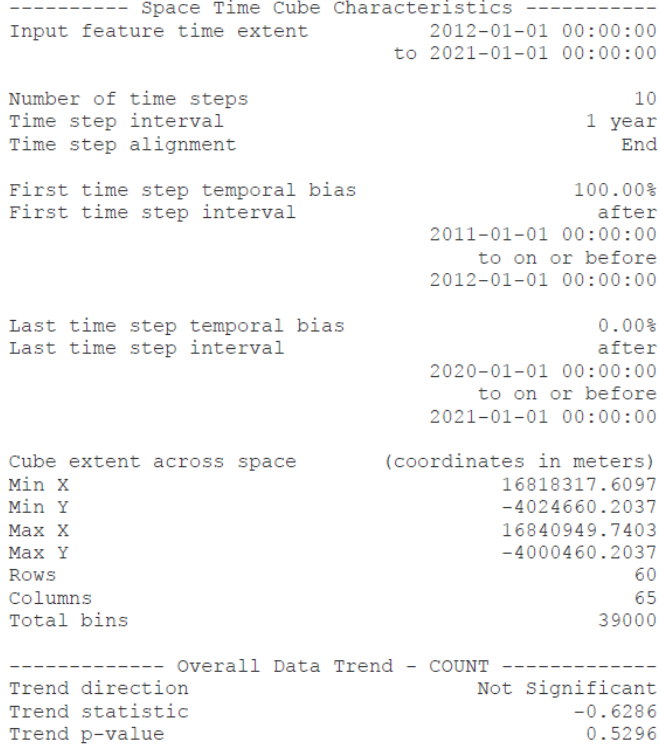
Figure A2. Hotel licence space-time cube logfile.